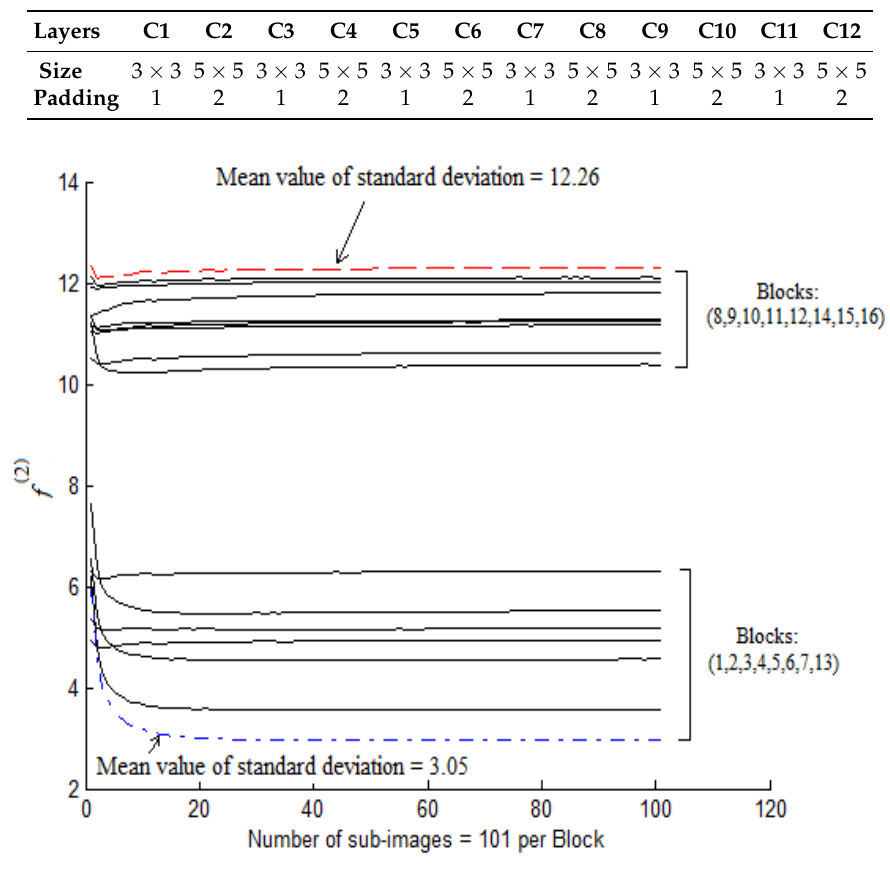
Figure 4. Standard deviation variation per